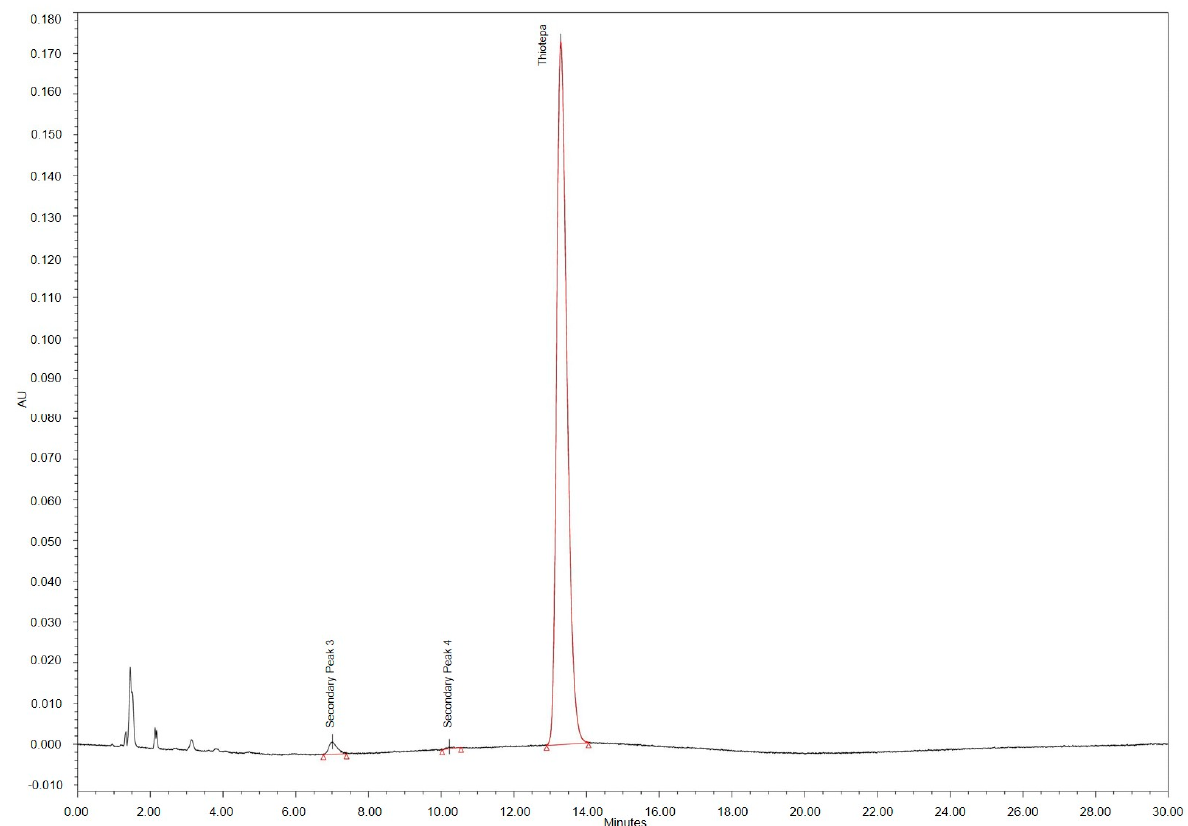
Figure 3. HPLC chromatogram of thiotepa 10 mg/mL concentrate after 14 days storage at 25 °C.